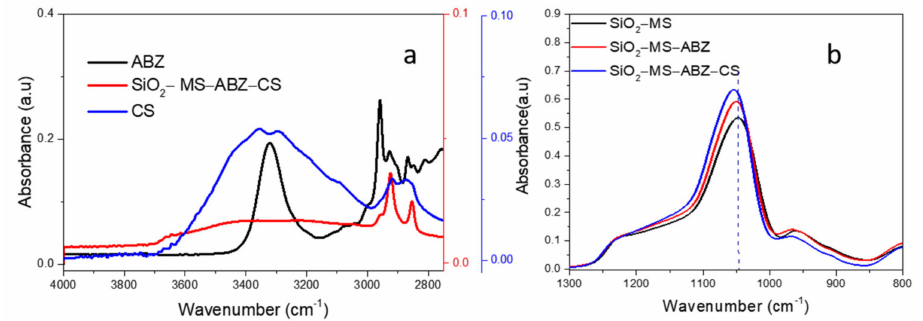
Figure 1. ( a ) High energy mid-FTIR region for ABZ, CS, and SiO 2 -MS-ABZ-CS, ( b ) low energy mid-FTIR region for SiO 2 -MS, SiO 2 -MS-ABZ, and SiO 2